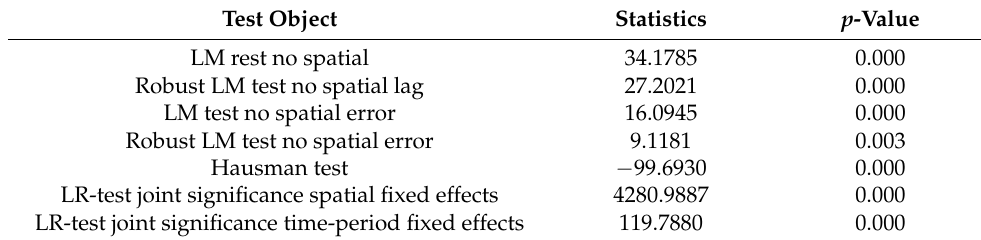
Table 6. A series of tests of the spatial econometric